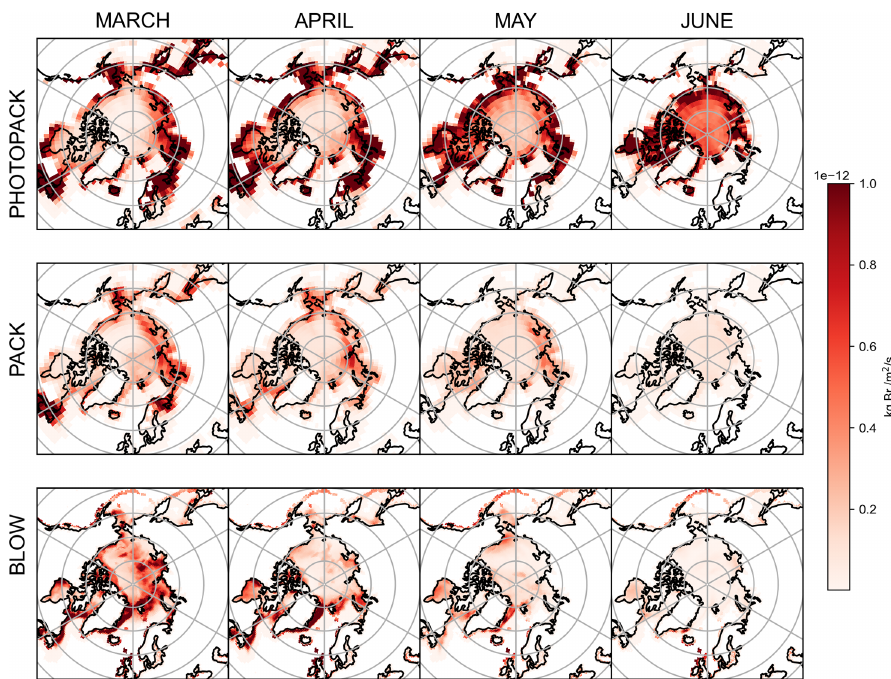
Figure 4. Mean snowpack Br 2 and p-Br − emissions by month, as simulated by GEOS-Chem. The top row shows emissions of Br 2 in the PHOTOPACK run, the middle row shows the emissions of Br 2 in the PACK run, and the bottom row shows emissions of p-Br − from adding the BLOW